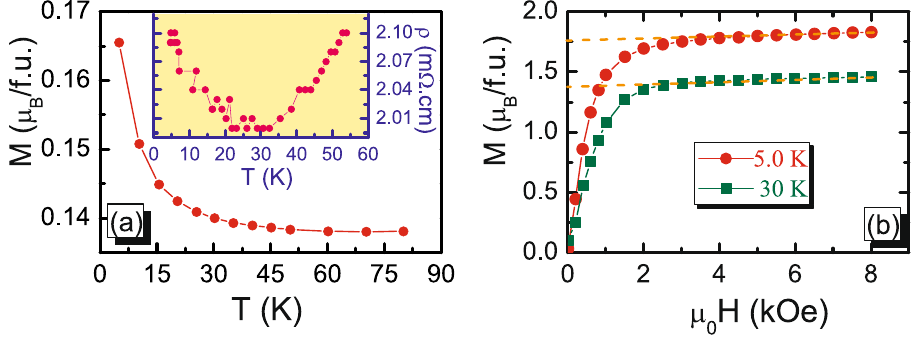
Figure 5. ( a ) Temperature dependence of magnetization at low temperature and inset shows the magnifying plot of resistivity as a function of temperature at low temperature. ( b ) Isothermal magnetization measured at 5.0 and 30 K for La 0.6 Er 0.1 Sr 0.3 MnO 3